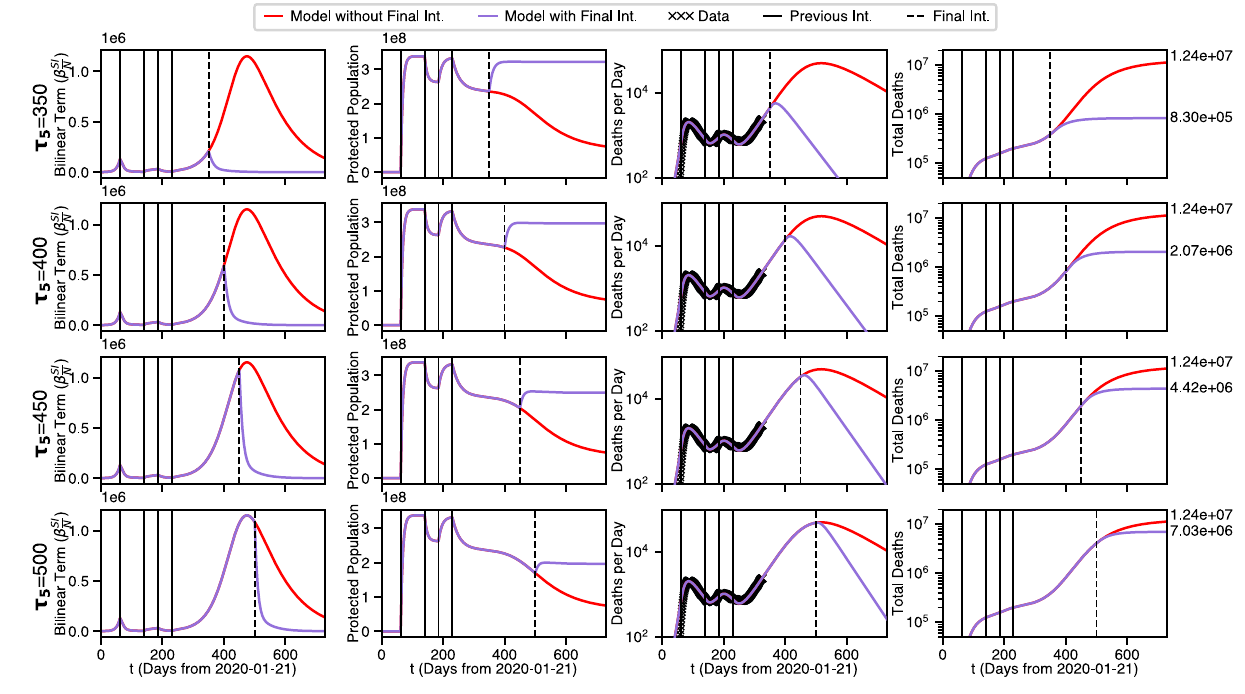
Figure 5. Four possible final intervention time scenarios.